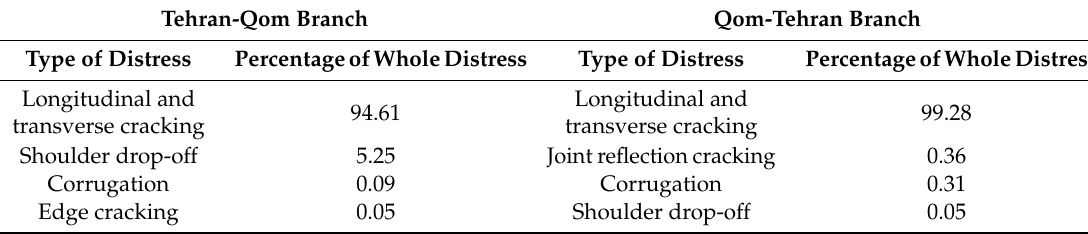
Table 6. Longitudinal Distresses in Tehran-Qom